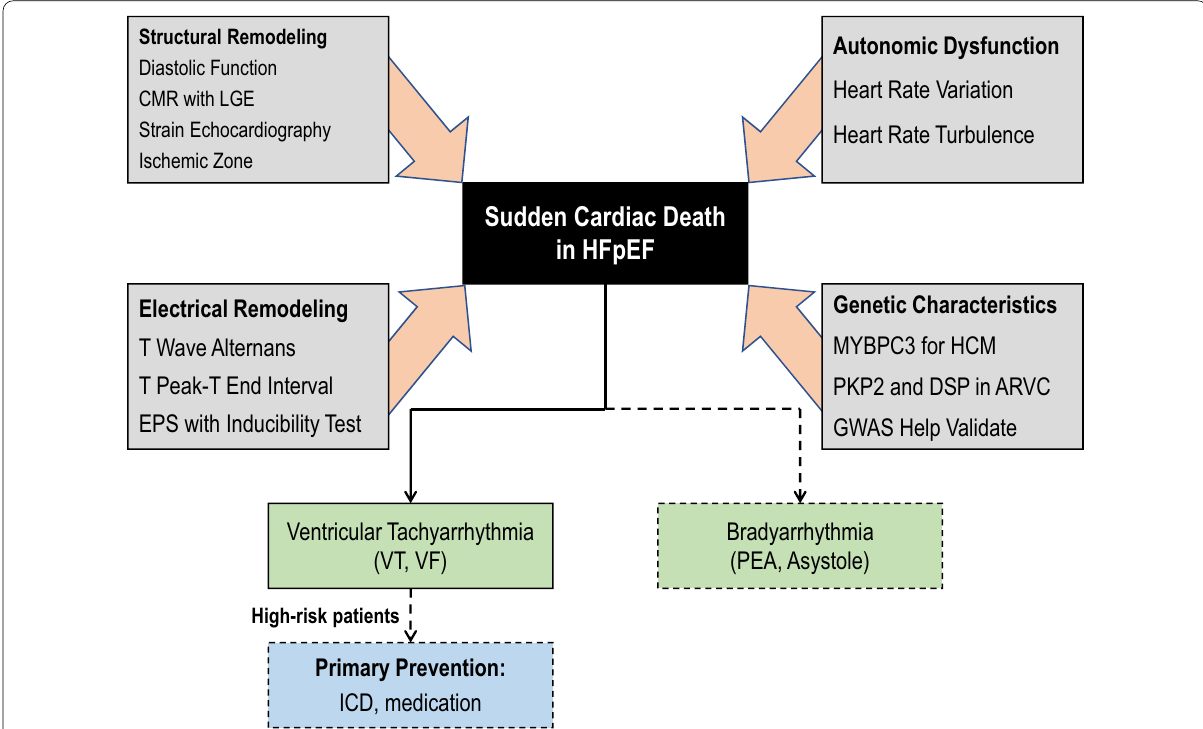
Fig. 1 Four pillars of sudden cardiac death in HFpEF and relevant mechanisms. Dash lines mean need of more literature to elucidate. Abbreviation: HFpEF (heart failure with preserved ejection fraction); CMR (cardiac magnetic resonance); LGE (late gadolinium enhancement); HCM (hypertrophic cardiomyopathy); ARVC (arrhythmogenic right ventricular cardiomyopathy); GWAS (genome‑wide association studies), VT (ventricular tachycardia);